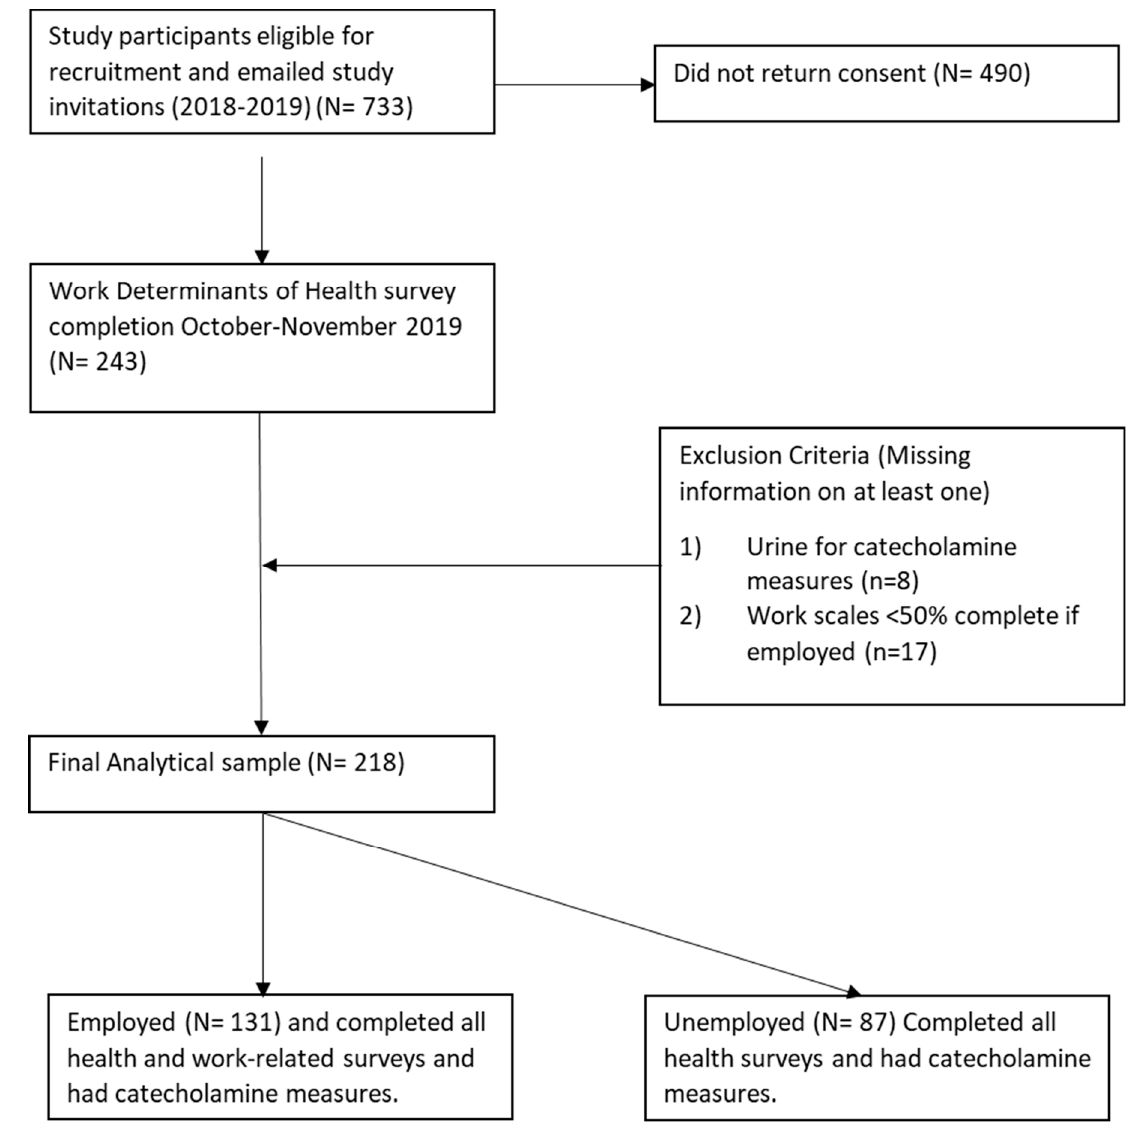
Figure 1. CONSORT Flow Diagram.